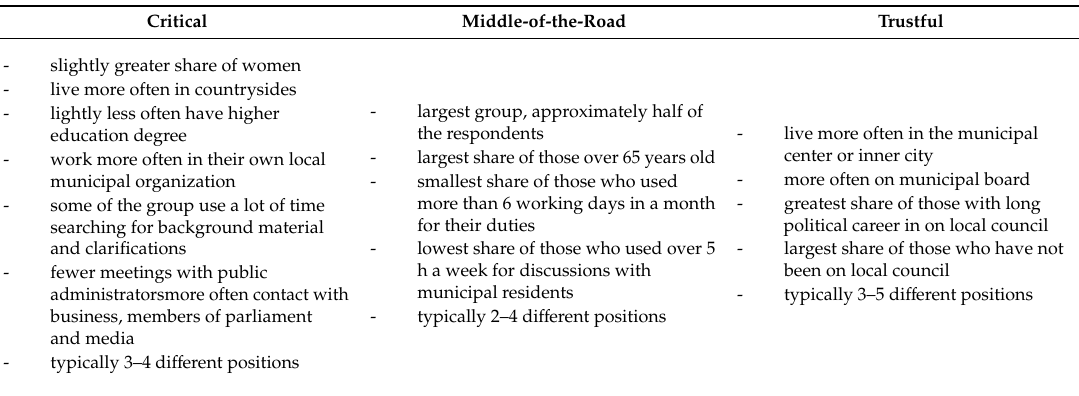
Table 7. Some characteristics of the three